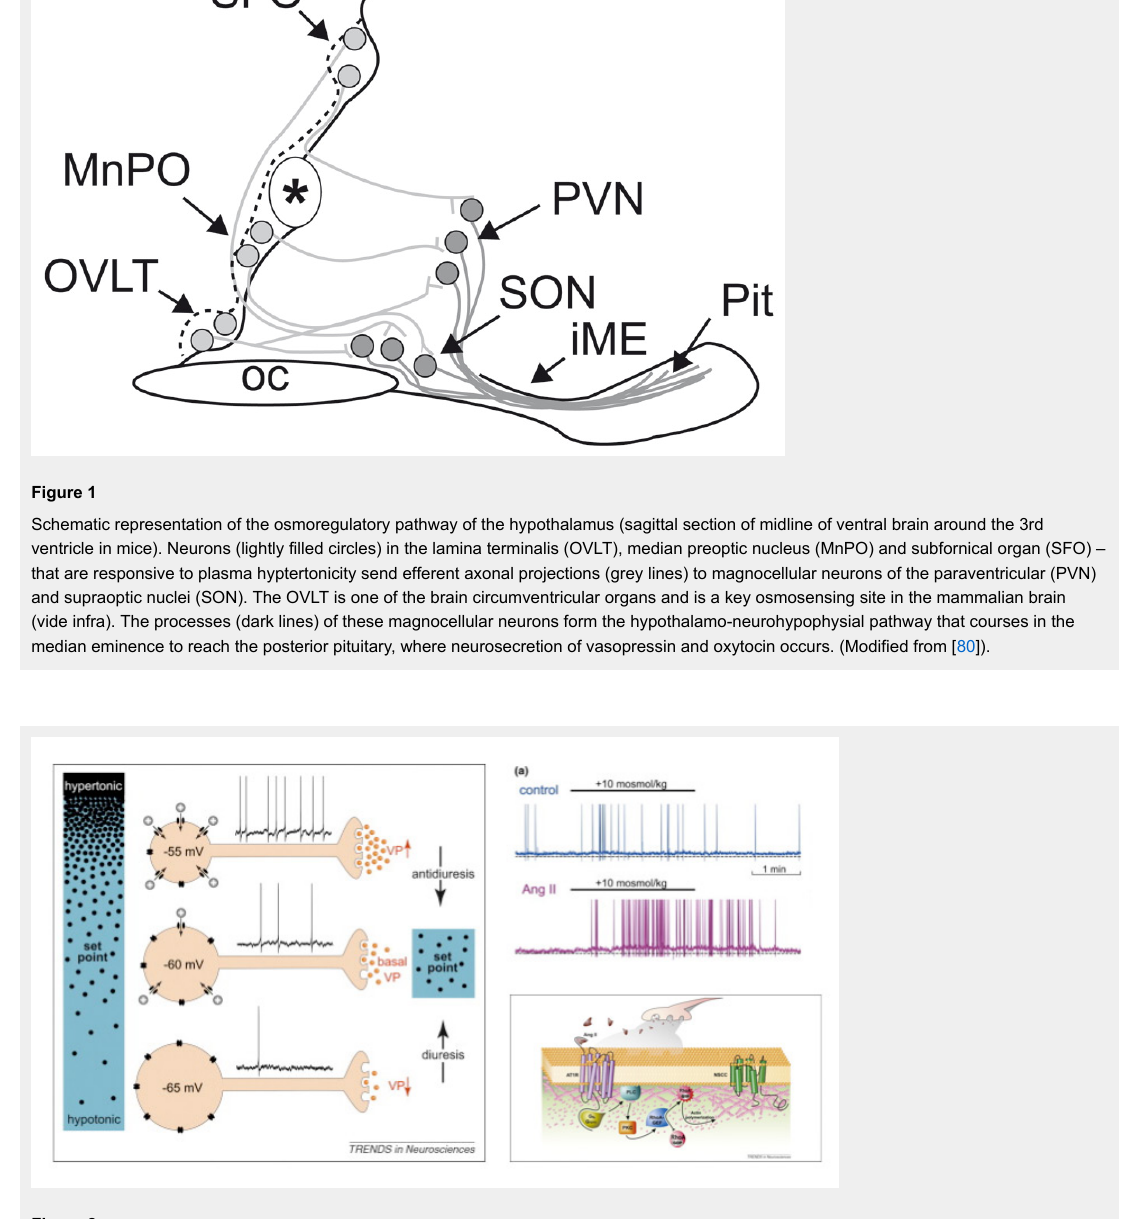
Upper left: Cell autonomous osmoreception in vasopressin neurons. Changes in osmolality cause inversely proportional changes in soma volume. Shrinkage activates nonselective cation channels (NSCCs) and the ensuing depolarisation increases action potential firing rate and vasopressin (VP) release from axon terminals in the neurohypophysis. Increased VP levels in blood enhance water reabsorption by the kidney (antidiuresis) to restore extracellular fluid osmolality toward the set point. Hypotonic stimuli inhibit NSCCs. The resulting hyperpolarization and inhibition of firing reduces VP release and promotes diuresis. Upper right: Whole cell current clamp recordings from isolated MNCs (left) and averaged data from multiple cells show that the depolarising and action potential firing responses induced by a hypertonic stimulus are significantly enhanced in the presence of 100 nM Ang II. Lower right: Hypothetical events mediating central Ang II enhancement of osmosensory gain. Ang II released by afferent nerve terminals (e.g. during hypovolaemia) binds to AT1 receptor (AT1R) coupled to G proteins such as Gq or/and G12/13. Activated G proteins signal through phospholipase C (PLC) and protein kinase C (PKC) to activate a RhoA-specific guanine nucleotide exchange factor (RhoA–GEF), such as p115RhoGEF or LARG (leukaemia-associated Rho guanine–nucleotide exchange factor) Activation of RhoA–GEF converts inactive cytosolic RhoA (RhoA–GDP) into active, membrane-associated RhoA–GTP by promoting the exchange of GDP to GTP. Activated RhoA induces actin polymerisation and increases submembrane F-actin density to enhance the mechanical gating of non-specific cation channels. (From [81]: Prager-Khoutorsky M, Bourque CW. Osmosensation in vasopressin neurons: changing actin density to optimize function. Trends Neurosci. 2010;33:76–83. © Elsevier, Oxford, UK, with kind